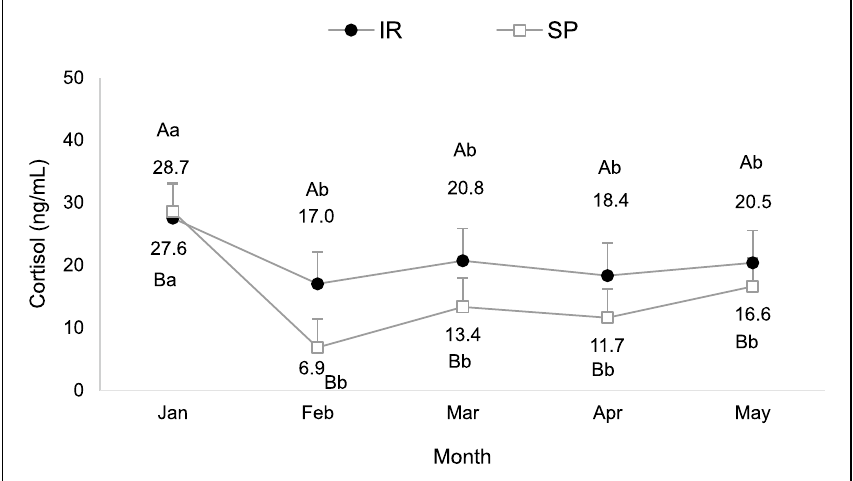
Figure 8. Serum cortisol concentration of heifers kept in the silvopastoral (SP) or intensive rotational (IR) grazing systems from January to May 2017. Cortisol levels were influenced by the system (P = 0.08) and the month (P = 0.02). A,B Different capital letters indicate a significant difference between systems. a,b,c Different lowercase letters indicate a significant difference between